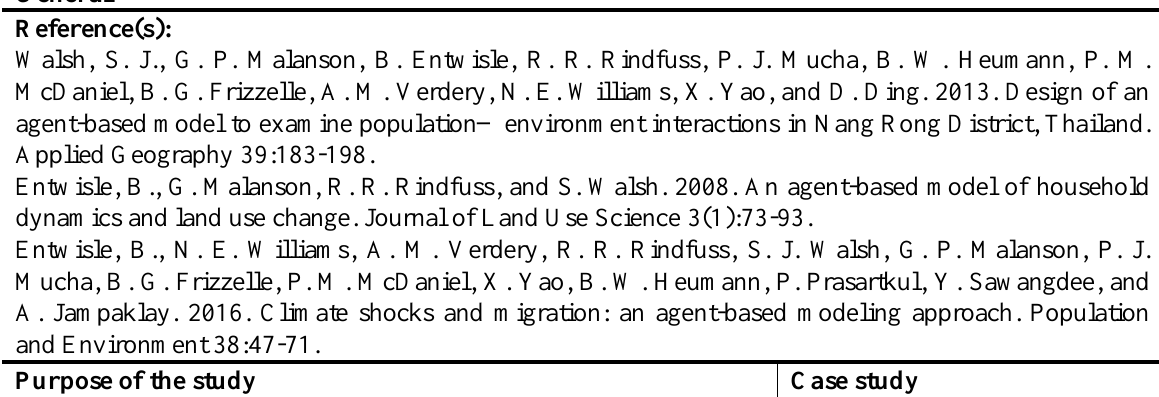
Fig. A1.14 Diagram drafted for the ABM described by Walsh et al. (2013) and Entwisle et al. (2008; 2016) Table A1.14 Standardized protocol for the ABM described by Walsh et al. (2013) and Entwisle et al. (2008;